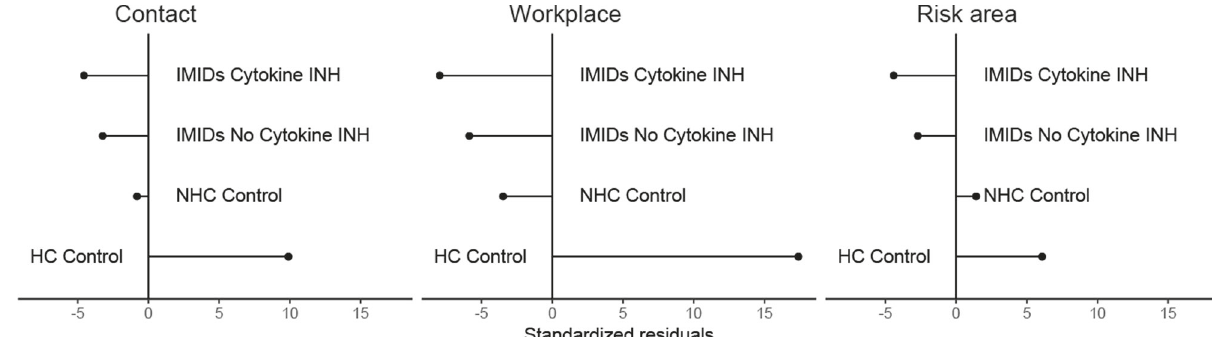
Fig. 2 Exposure risk across study groups. Standardized residuals showing deviation from the expected frequencies for exposure risk variables (contact with persons with a respiratory infection, presence at workplace outside home, travel to risk areas) of IMID patient groups and control groups. A Pearson residual quanti fi es the individual contribution of each cell in a contingency table to the chi-squared statistic of the table and is calculated by subtracting the expected count in a cell from the observed count and dividing the result by the standard error. A Pearson residual is 0 when the observed cell frequency is equal to the expected and deviates from 0 accordingly as the observed cell frequency is greater or less than the expected count.